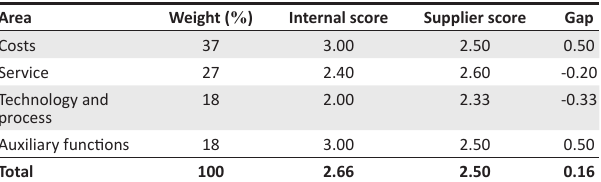
TABLE 4: Results.